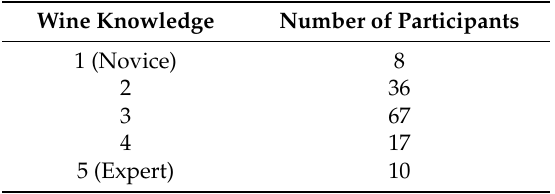
Table 2. The wine knowledge distribution of participants. Wine Knowledge